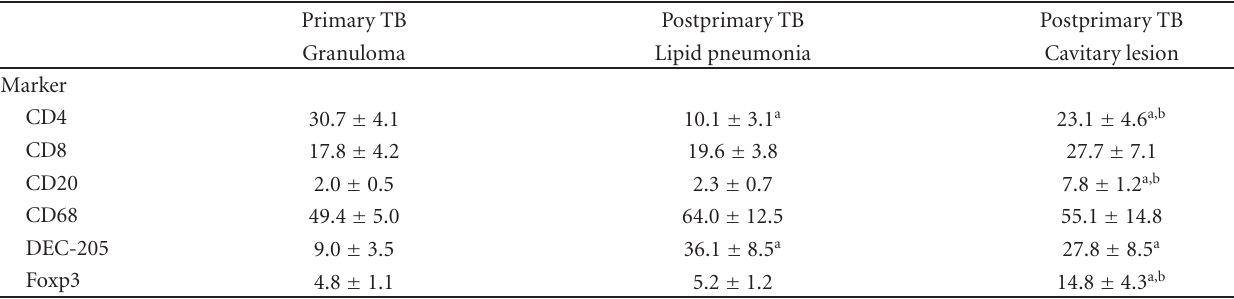
Table 2: Percentage of cells positive for immunological markers.